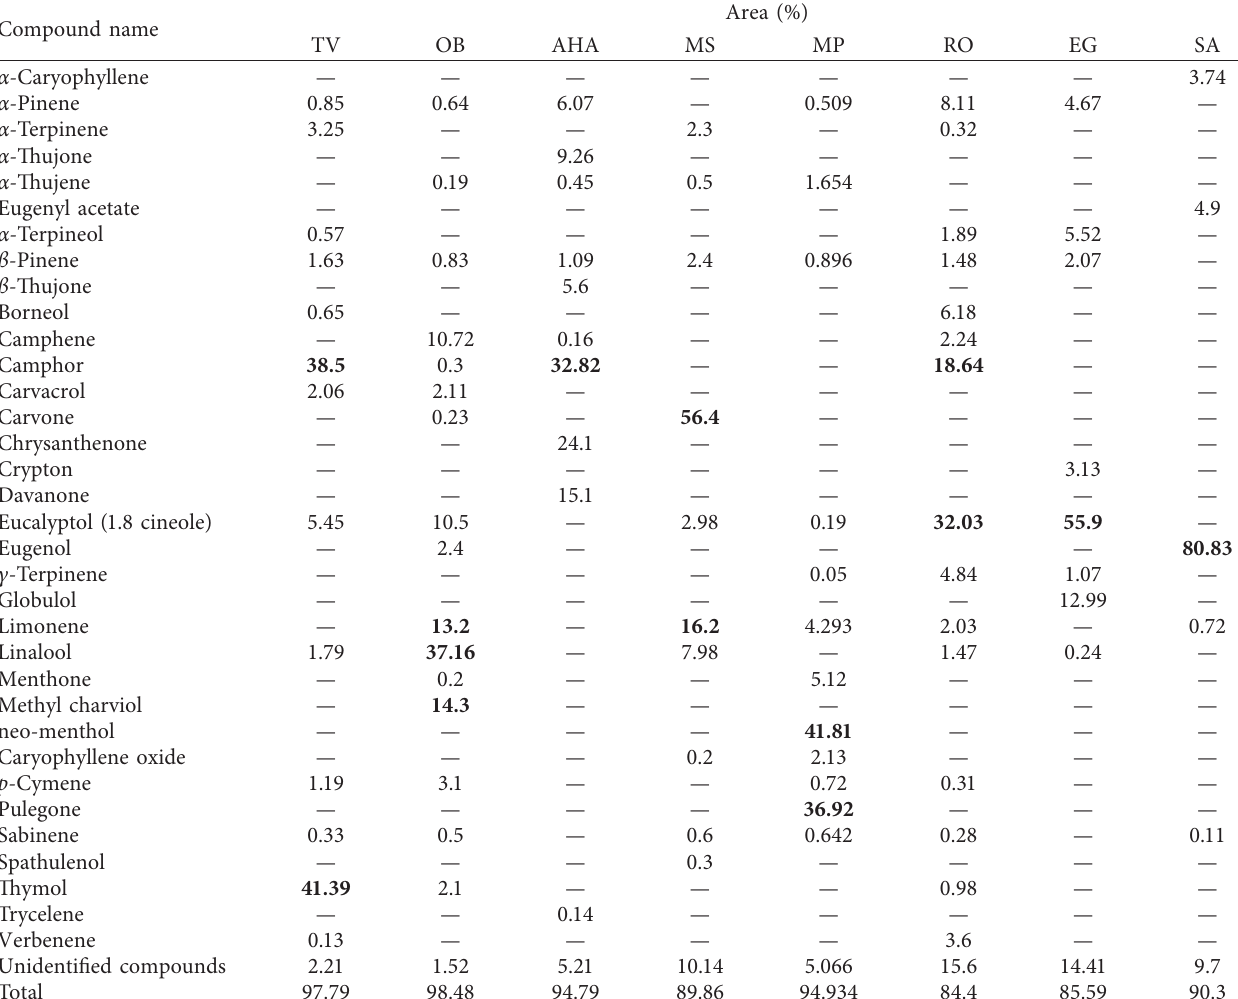
Table 3: Chemical composition of eight essential oils obtained by